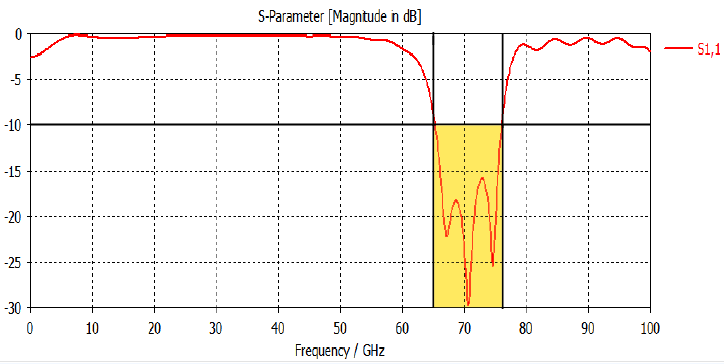
Figure 8. S 11 parameter of the simulated design .